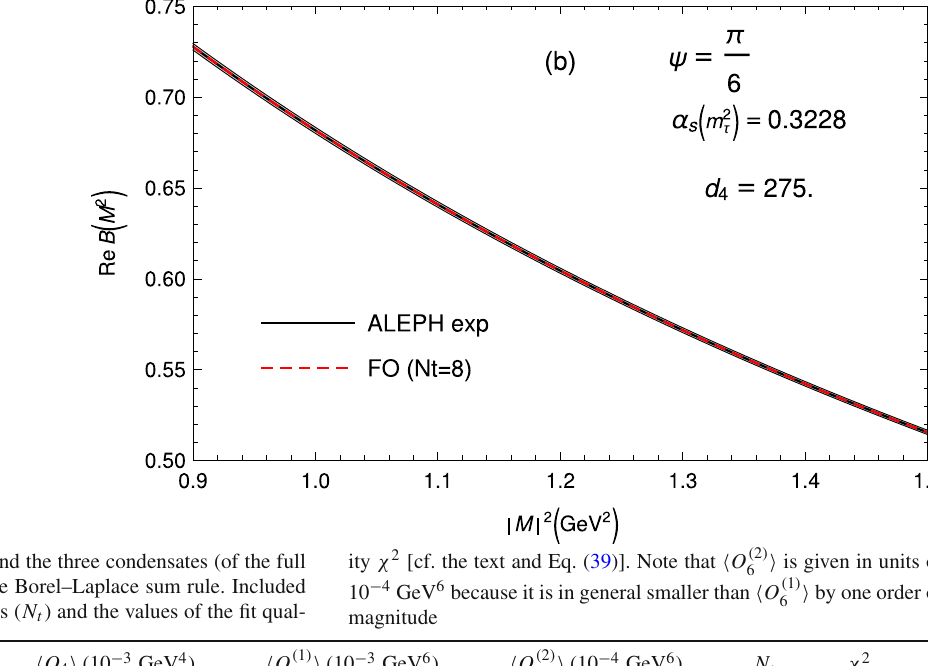
Fig. 3 The values of Re B ( M 2 ; σ m ) along the ray M 2 = | M 2 | exp ( i (cid:17)) with (cid:17) = π/ 6. The narrow grey band are the experimental predictions. The red dashed line inside the band is the result of the FOPT global fit with truncation index N t = 8. For (cid:17) = 0 and π/ 4, similarly good fitted curves are obtained